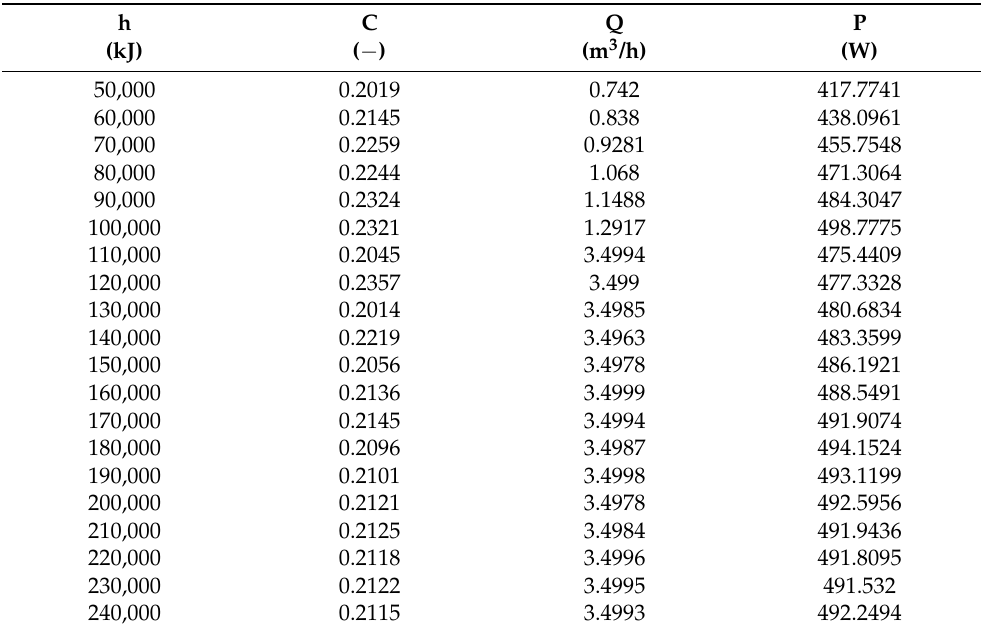
Table 3. C, Q, and P data of different h.